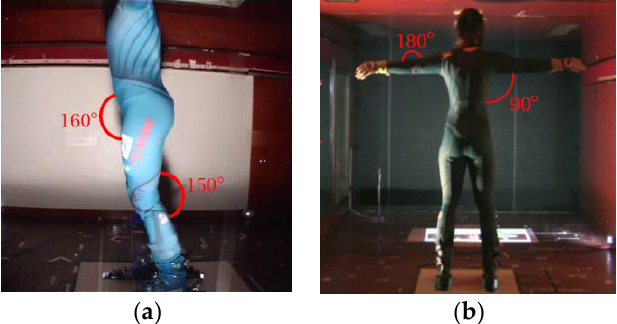
Figure 1. Test subject standing in the reference position. Picture ( a ) showing the side view and picture ( b ) the rear